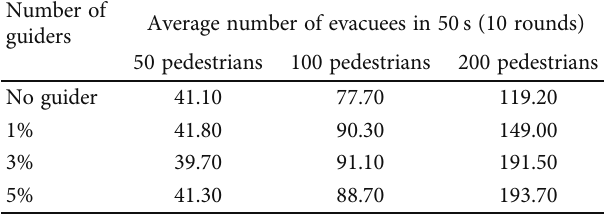
Table 5: Average number of outside pedestrians of ten trial runs. 50, 100, and 200 individuals with 0%, 1%, 3%, and 5% guiders are considered in simulations. The simulation domain is a room with two exits as Figure 3(b). The entire time period of a simulation is